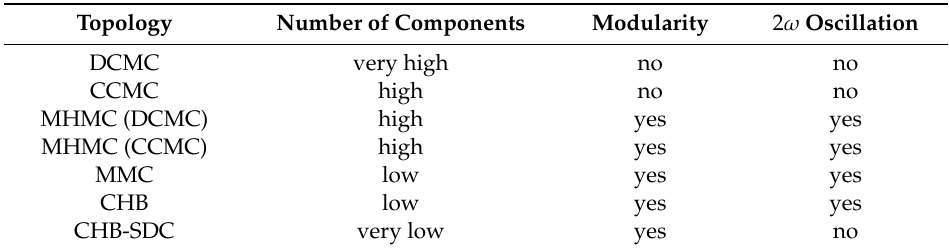
Table 1. Comparison between multilevel